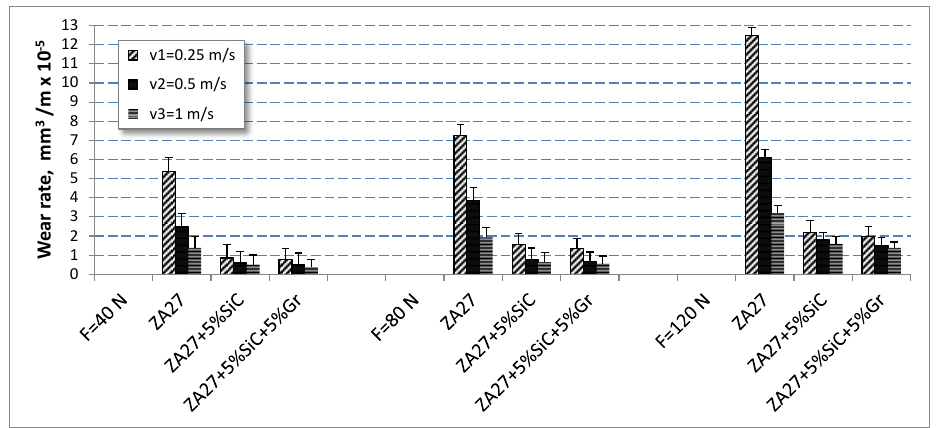
Figure 7. The wear-rate of the tested materials.